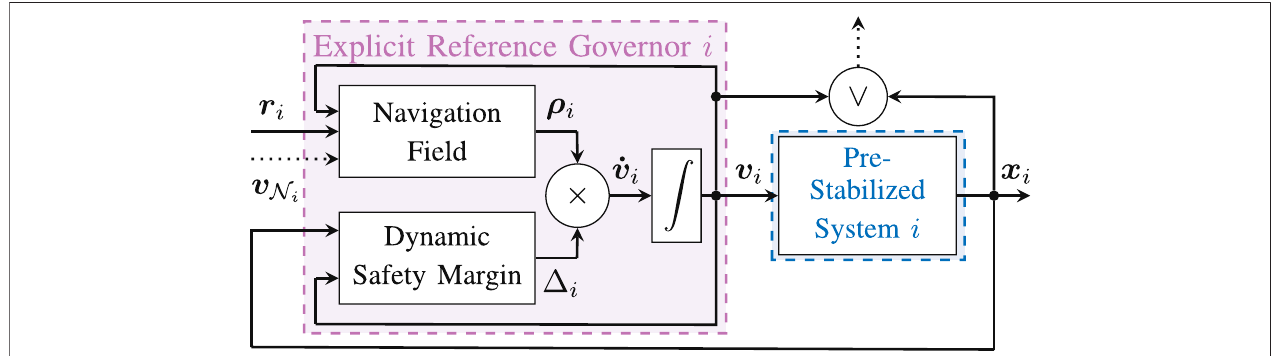
FIGURE 5 | DistributedExplicitReferenceGovernor(D-ERG)SchemeforAgent i .Toensurethattheconstraintsaresatis fi edforanydesiredreferencecon fi guration r i ,the ERG manipulates the rate of change of the applied reference _ v i by computing a suitable Navigation Field (NF) ρ i and a Dynamic Safety Margin (DSM) Δ i . The NF determines the current direction of _ v i and the DSM regulates the modulus of _ v i such that dynamic transients do not cause constraint violations. Agent i relies on the signal v N Figure2 ,thatisavailableinitslocalone-hopneighborhoodandcommunicatesitsownsignals